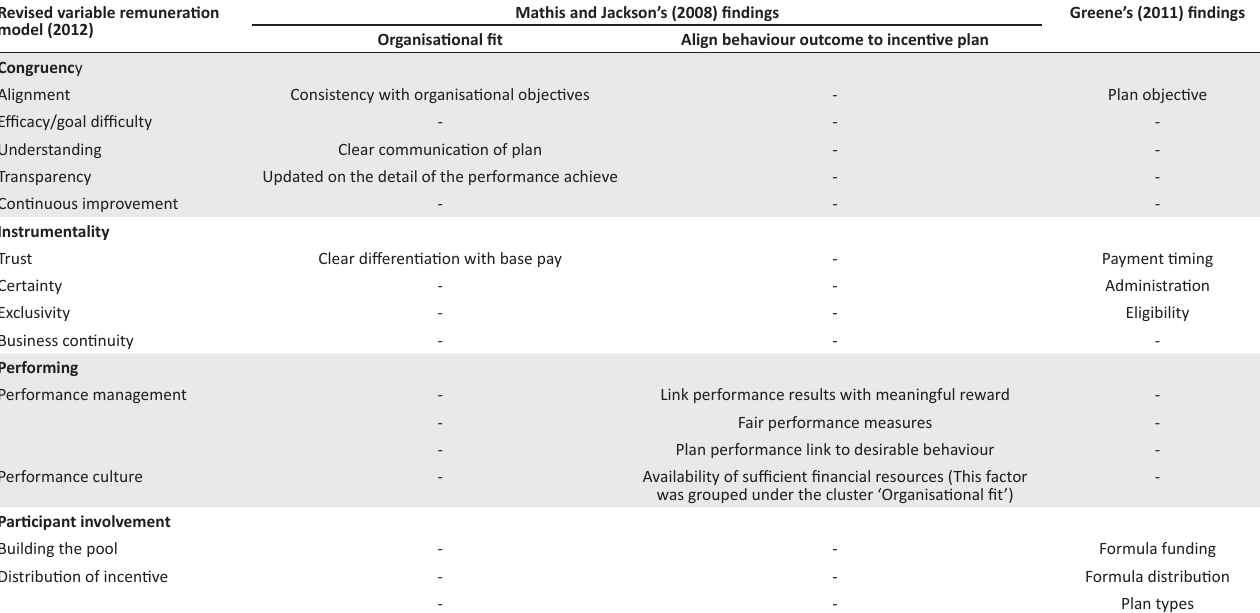
TABLE 3: Synergies between research on variable pay plans.